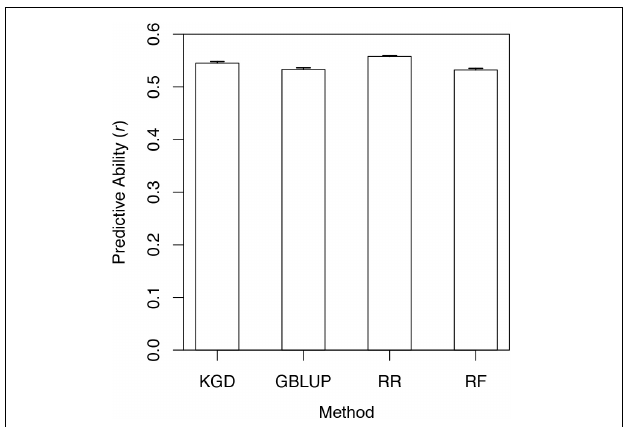
FIGURE 3 | Mean ( n = 5) 10-fold cross-validation predictive ability in a perennial ryegrass training set for % viable endophyte transmission, determined using four statistical models and assessed as Pearson correlation between observed phenotype (BLUP-adjusted mean) and GEBV. The RR model used 249,546 SNPs (largest SNP dataset able to be dealt with computationally by this method) while GBLUP, KGD, and RF used 1,023,011 SNPs. Error bars are standard errors.